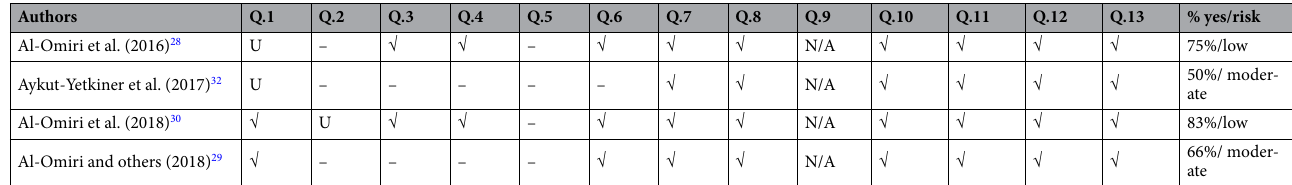
Table 3. Risk of bias assessed by the JBI Manual for Evidence Synthesis. The risk of bias was classified as high when the study reached up to 49% of "yes" score, moderate when the study reached from 50 to 69% of "yes" score, and low when the study reached more than 70% of "yes" score. Q.1—Was true randomization used for assigning the participants to treatment groups? Q.2—Was allocation to groups concealed?